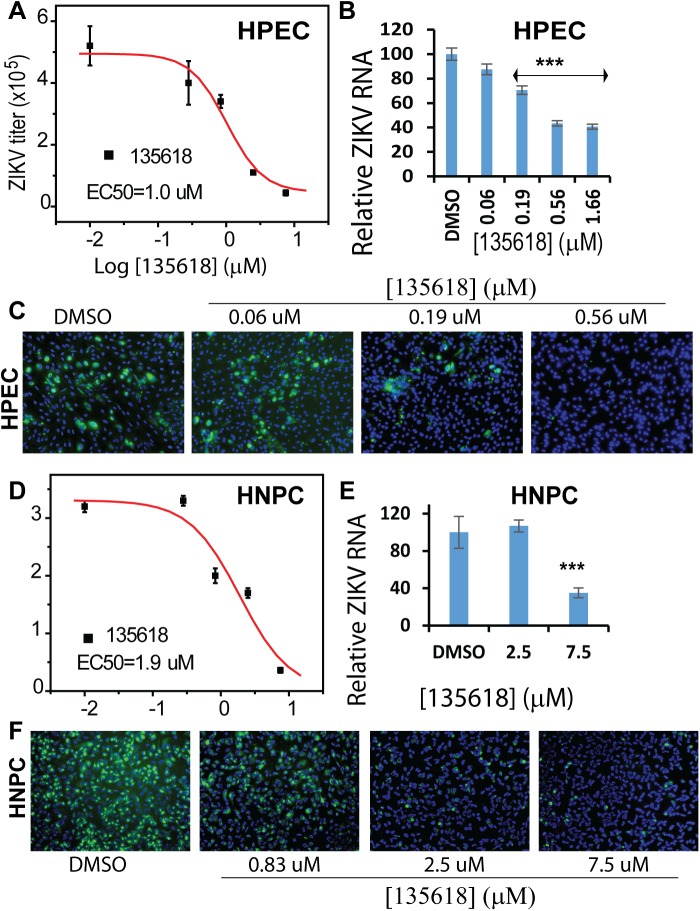
Inhibition of ZIKV in cells relevant to ZIKV by NSC135618.(A,D) Dose-dependent inhibition of ZIKV by NSC135618 in human placental epithelia cells (HPECs) (A) and human neural progenitor cells (hNPCs) (D). (B,E) qRT-PCR analyses of inhibition of viral RNA from supernatant of ZIKV infected HPECs (B), and hNPCs (E) by NSC135618. N = 3. ***, p<0.001, by one-way ANOVA. (C,F) IFA of inhibition of viral protein expression for ZIKV-infected HPECs (C), and hNPCs (F) by NSC135618, using pan flavivirus anti-E antibody 4G2. For all these primary cells, the experiment was performed as described in A549 cells except that ZIKV with MOI of 2 were used. All dose response curves were fitted with the Sigmoidal model using the Origin6.0 software suite.